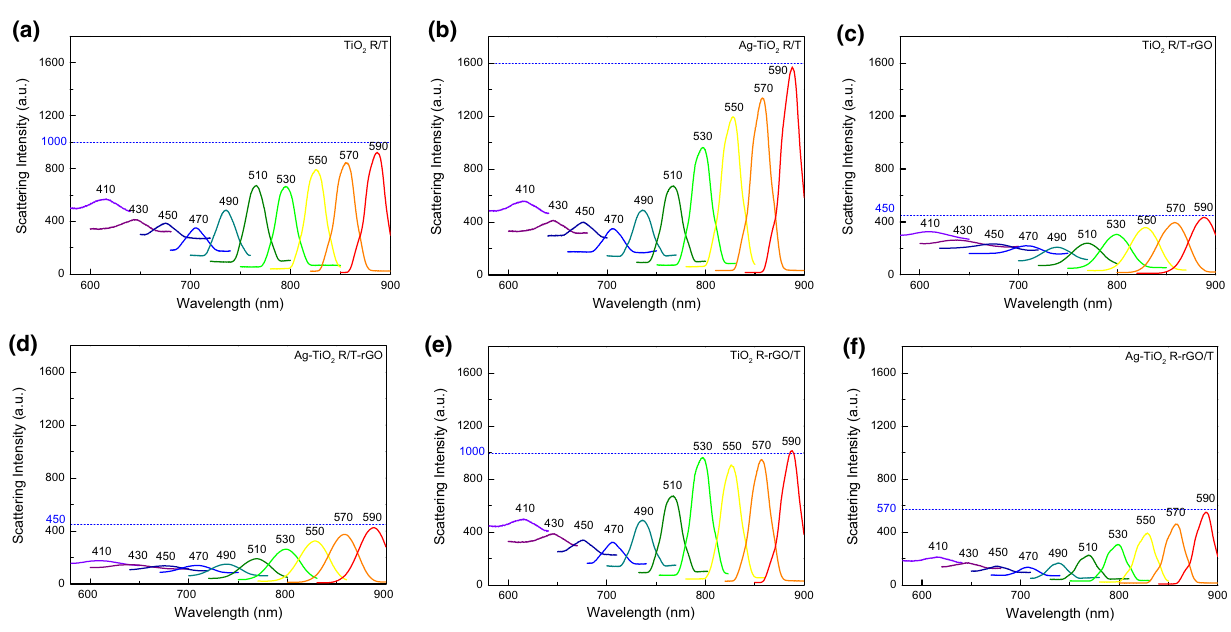
Fig. 6 Scattering spectra with different excited wavelength of a TiO 2 R/T, b Ag-TiO 2 R/T, c TiO 2 R/T-rGO, d Ag-TiO 2 R/T-rGO, e TiO 2 R-rGO/T, and f Ag-TiO 2